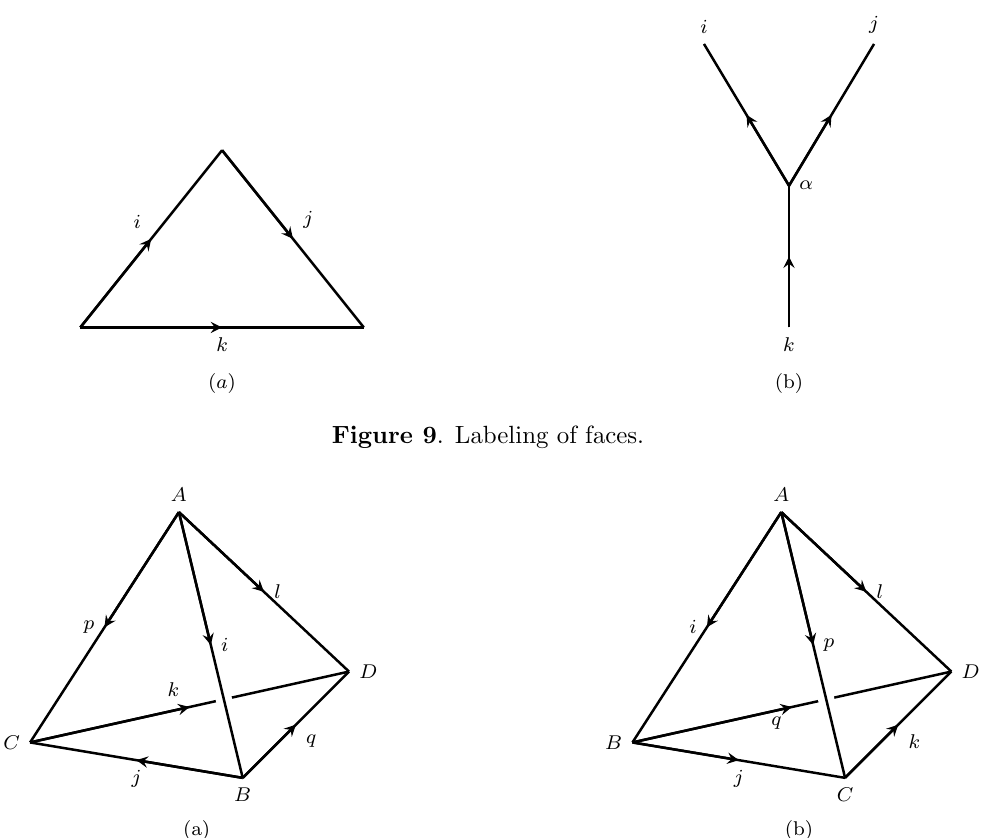
Figure 10 . A tetrahedron can have two chiralities | (a) positive and (b) negative. There is a label attached to every face but we don’t show it in the (cid:12)gure for brevity.